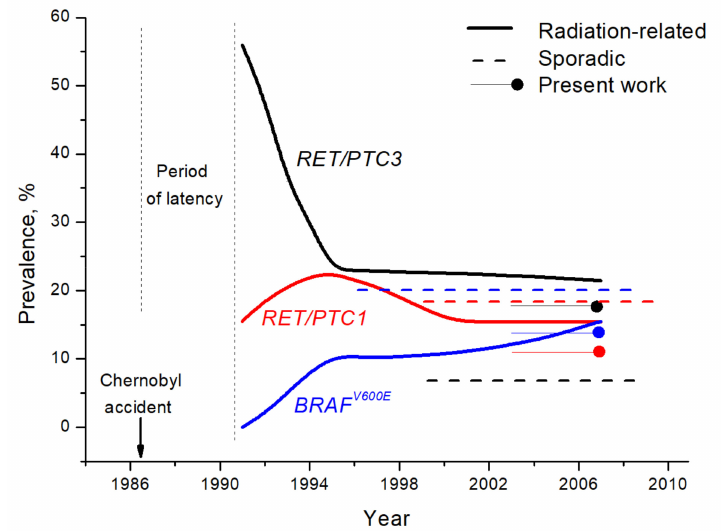
Figure 5. Tentative prevalence of BRAF V600E (blue lines), RET/PTC1 (red lines), and RET/PTC3 (black lines) in radiation-related and sporadic childhood/pediatric/young PTC patients from Belarus and Ukraine from 1991 to 2009. Data are summarized from the current work and the sources are listed in Supplementary Tables S2 and S3. The length of lines tentatively corresponds to the periods of